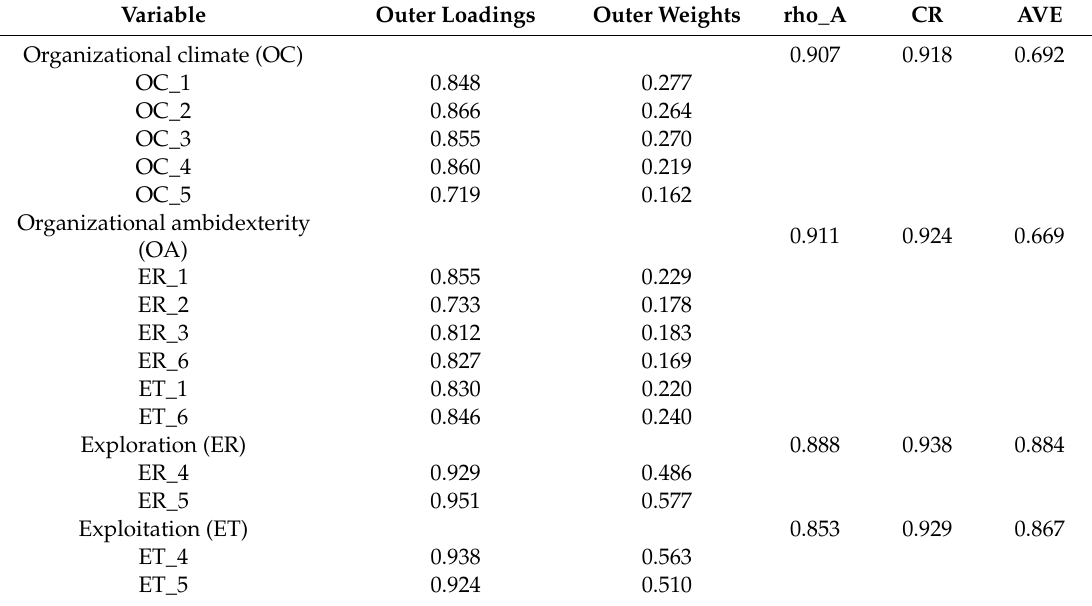
Table 1. Quantitative statistical description for the